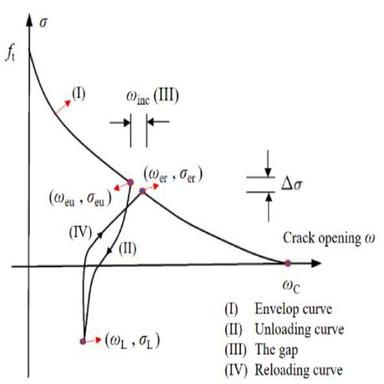
The description of continuous function model adapted from.